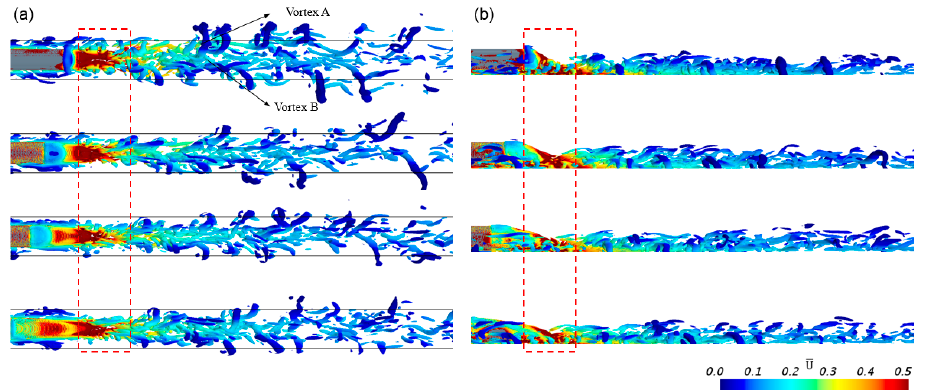
Figure 20. Instantaneous iso-surface plot of Q criterion (Q = 5000) colored by time-averaged U : ( a ) top view and ( b ) side view (from top to bottom: 4, 7, 9, and 12 m. Black line is 3 m from